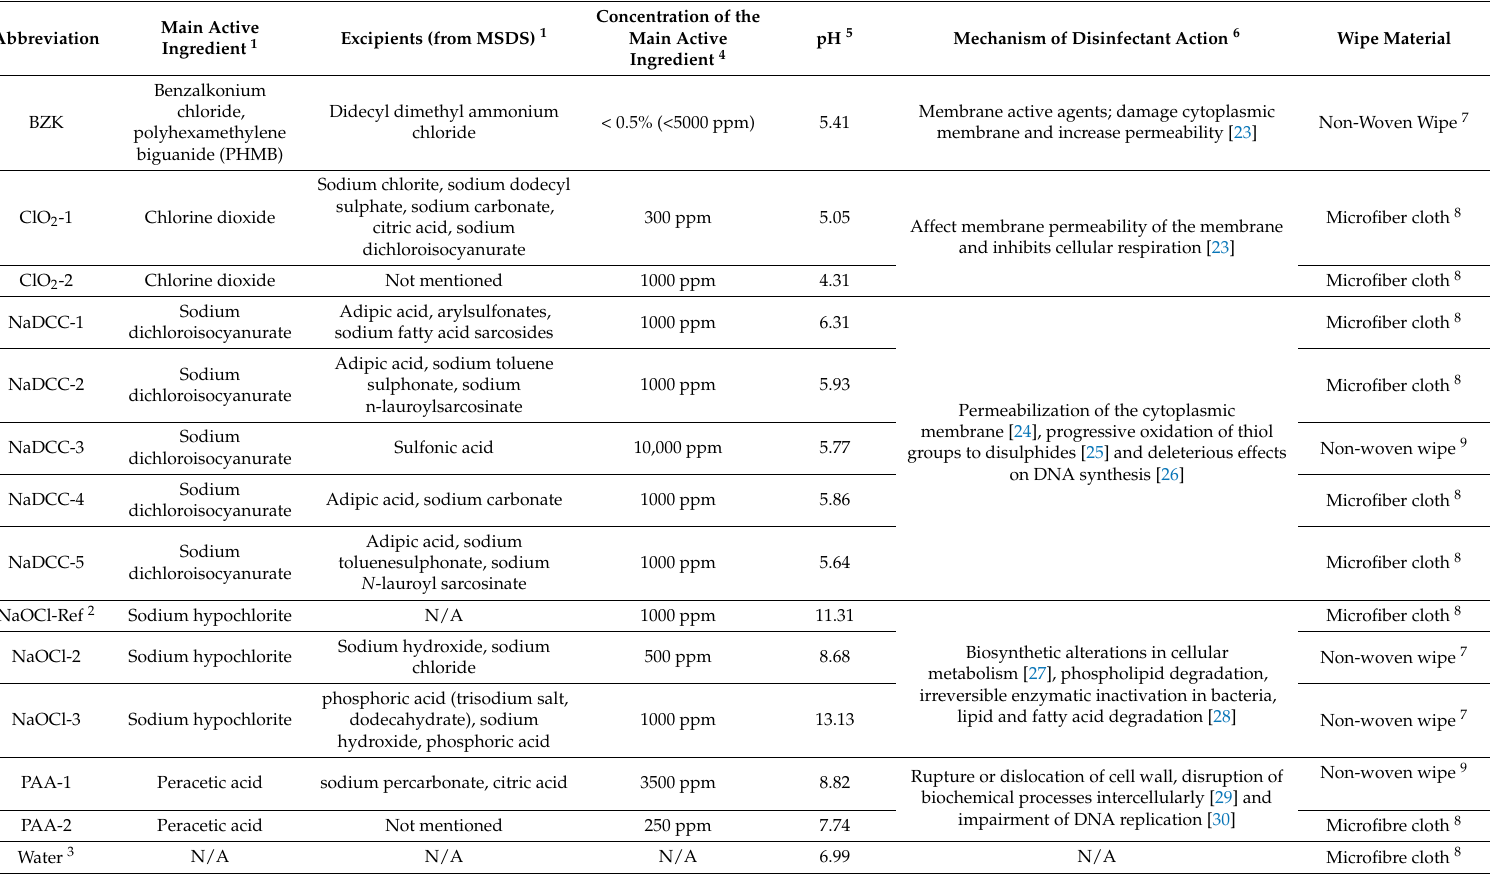
Table 1. Disinfectants